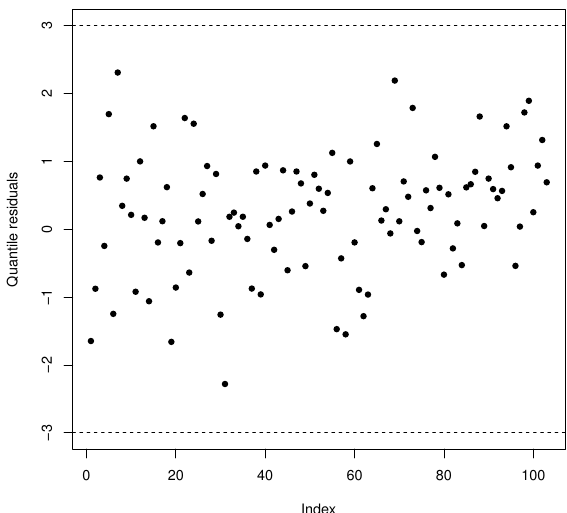
Figure 10. Index plot of the quantile